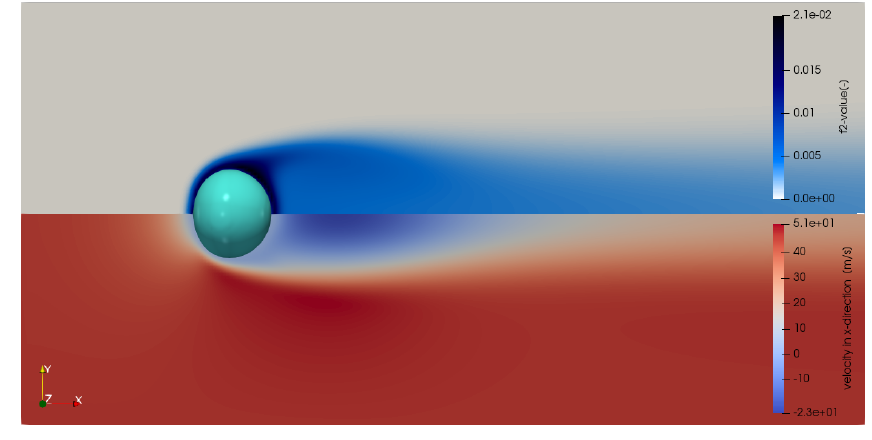
Figure 8. Contour plot of vapor field ( f 2 value) and velocity magnitude in mid cross section from converged DNS results at t = 4.87 × 10 − 5 s. Initial conditions were D = 75 µ m, u ∞ = 46.17m/s, T gas = 300K, T liquid = 295K, ϕ =